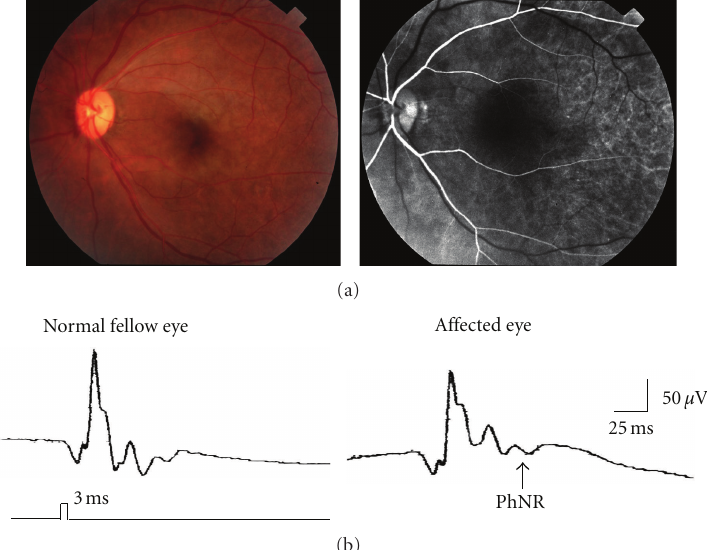
Figure 11: (a) Early recanalization of blood flow was seen by fluorescein angiogram. (b) The PhNR amplitude was considerably reduced in the a ff ected eye. PhNR: photopic negative